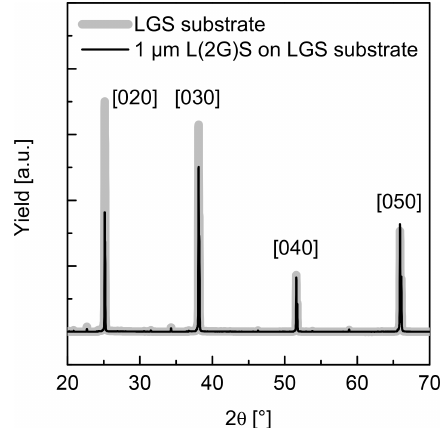
Figure 4. XRD patterns of an LGS substrate before (grey curve) and after (black curve) film deposition using the L(2G)S target with = 3Pa and 600 ◦ C. The film thickness deposition parameters of p O 2 of slightly more than 1µm is sufficient to get a reliable XRD signal of the film. The yield is given in arbitrary units